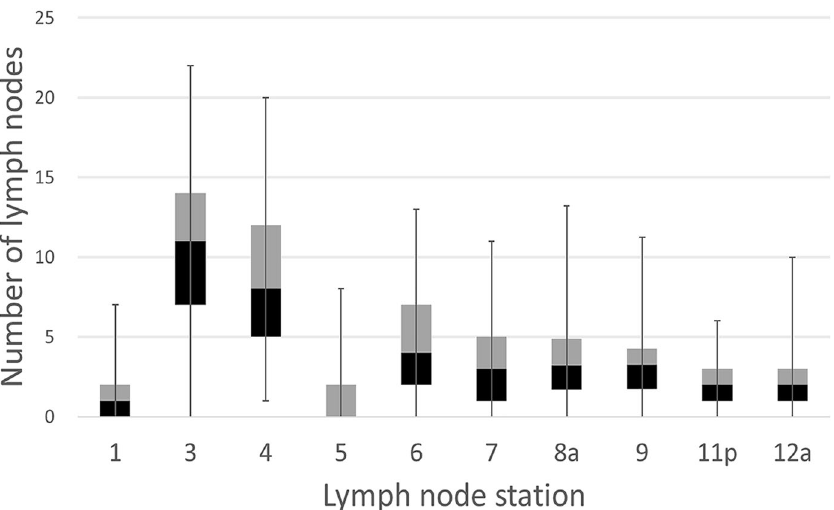
Figure 2. The number of dissected lymph nodes at each lymph node station. The most common station missing from lymph node retrieval at pathological examination was station no. 5 (35/65, 53.8%), followed by station no. 1 (24/65, 36.9%). However, station no. 4 was retrieved in all 65